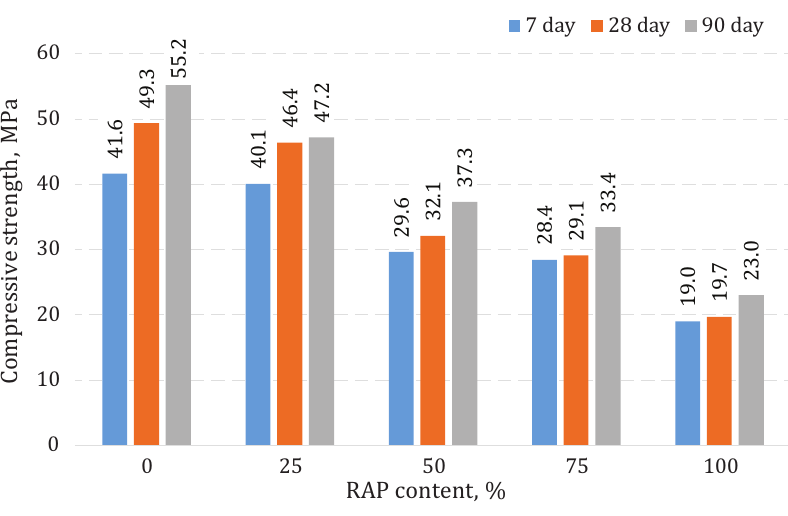
Figure 7. Compressive strength of mixtures containing different amounts of RAP